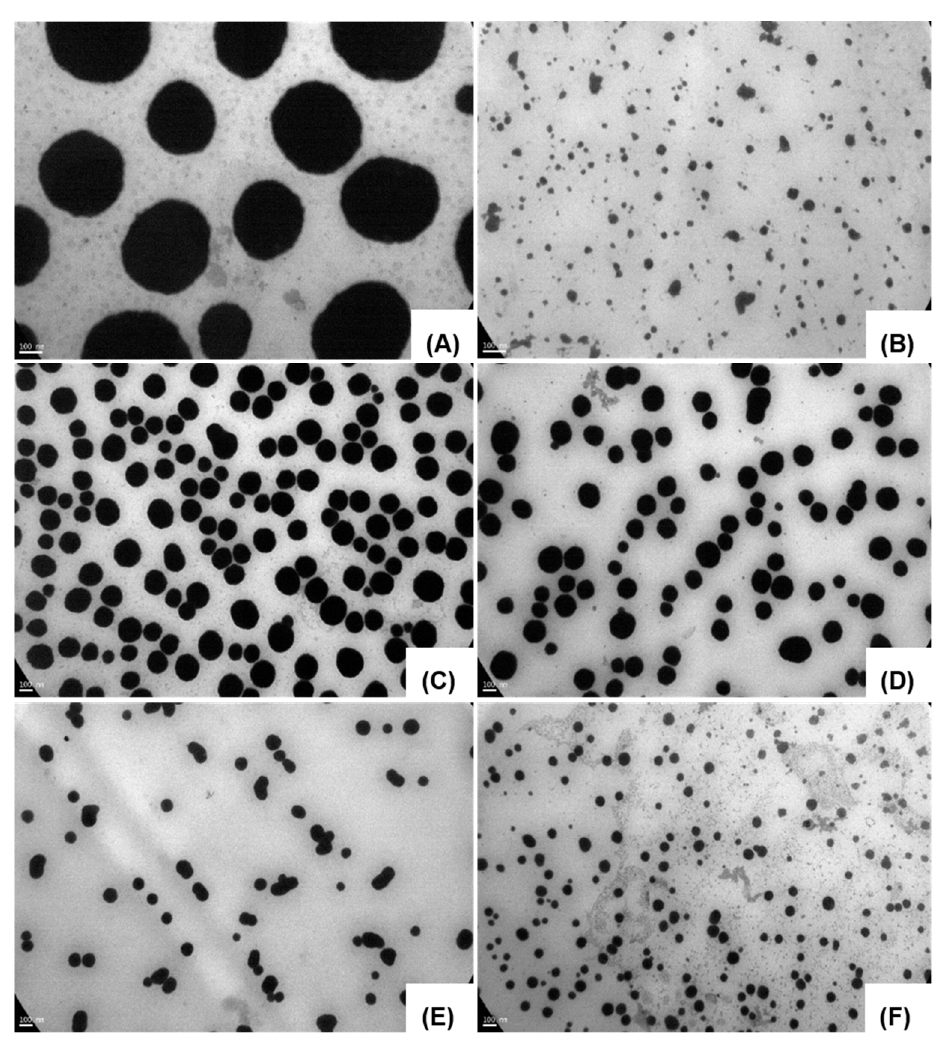
Figure 2. TEM images of pristine free-PMs (10% w/v): ( A ) F127, ( C ) T1307, and ( E ) T908 and co- associated PMs-probe ( B ) F127-probe, ( D ) T1307-probe, and ( F ) T908-probe. Scale bar: 100 nm. No- tice the evident reduction in the particle sizes post co-association between the probe and PMs ( B , D , F ).